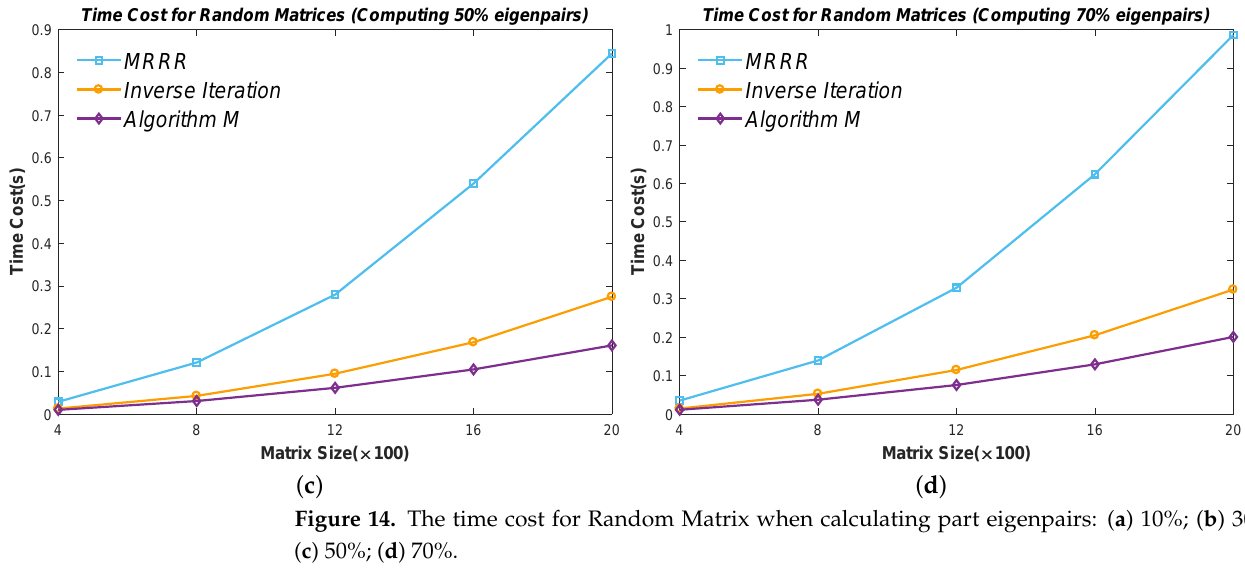
Figure 14. The time cost for Random Matrix when calculating part eigenpairs: ( a ) 10%; ( b ) 30%; ( c ) 50%; ( d )